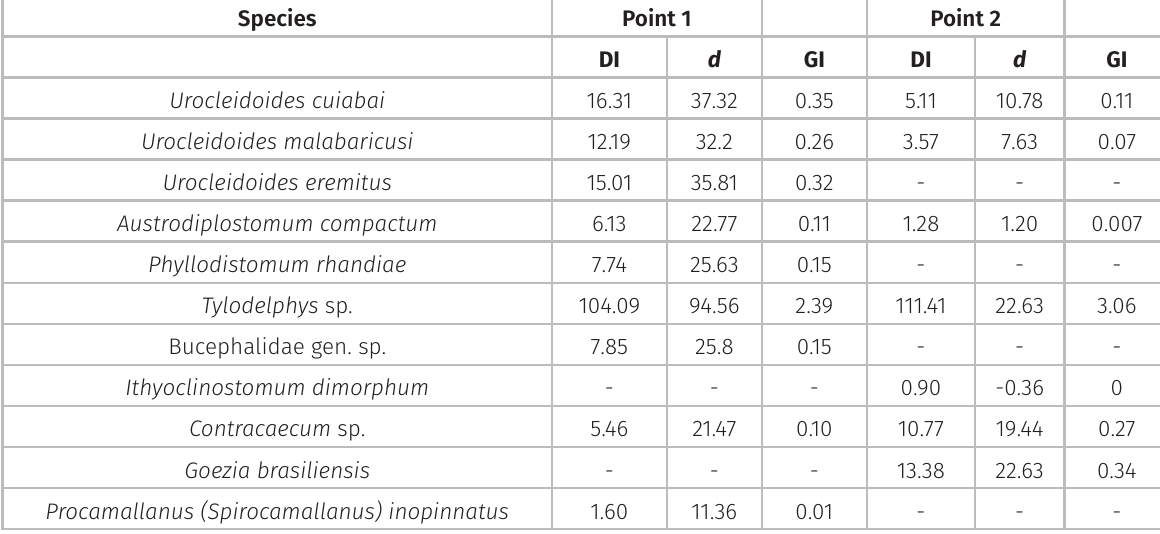
Table IV. Dispersion index (DI), Green’s index (GI) and statistical test d of each parasite species found in Hoplias malabaricus (Bloch, 1794) specimens collected at two points of the Batalha River in São Paulo State, Brazil, between February 2014 and June 2016.